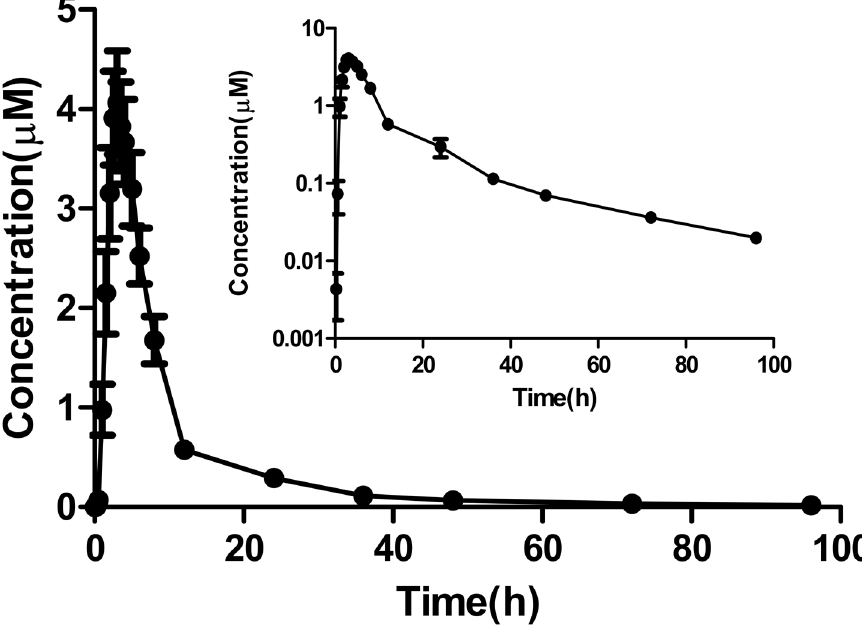
Fig 10. Plasma concentration – time profiles of CK in 10 healthy subjects after a single oral dose of 800 mg CK tablet. Inset depicts the same data on a semilogarithmic scale, each value is the mean value ±